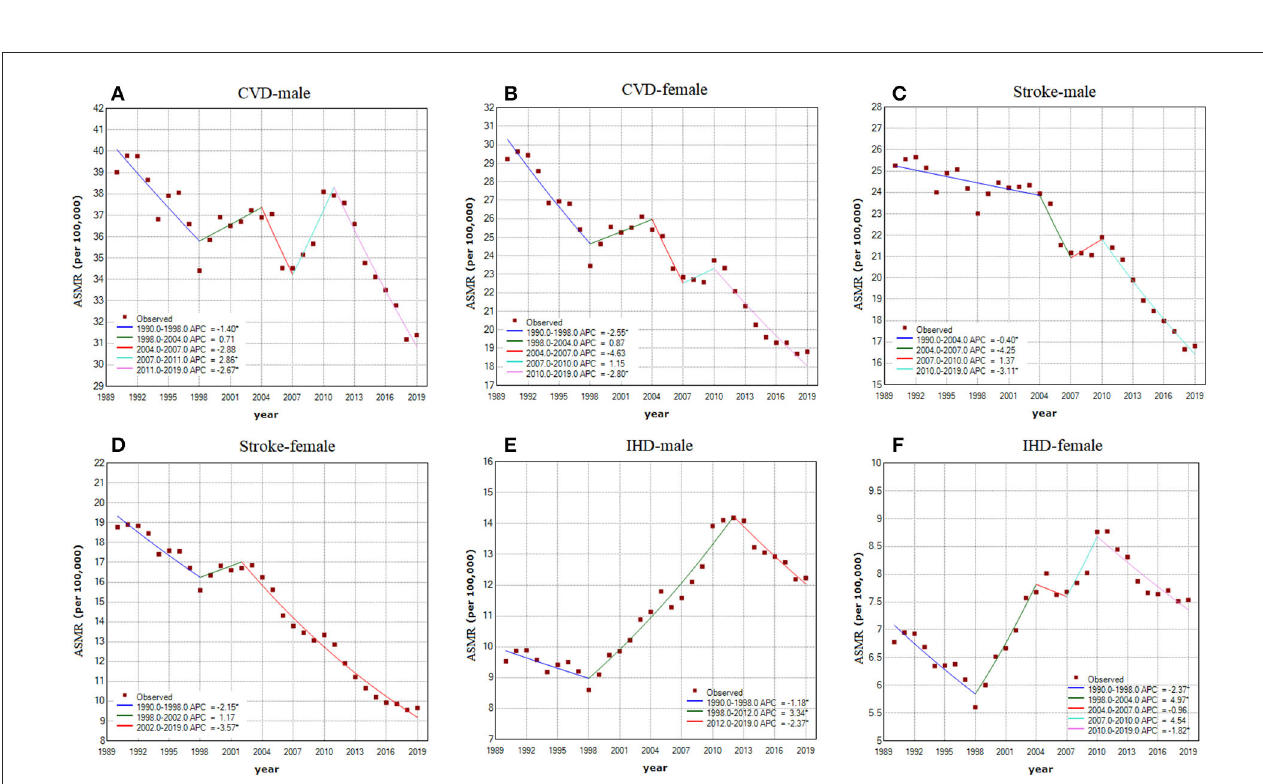
FIGURE3 Joinpoint regression analysis in sex-specific age-standardized mortality rate (ASMR) of CVD, stroke, and IHD attributable to non-optimal temperatures from 1990 to 2019. (A) CVD in males; (B) CVD in females; (C) stroke in males; (D) stroke in females; (E) IHD in males; (F) IHD in females. Notes: an asterisk indicates that the annual percent change is statistically significantly different from zero at the α = 0.05